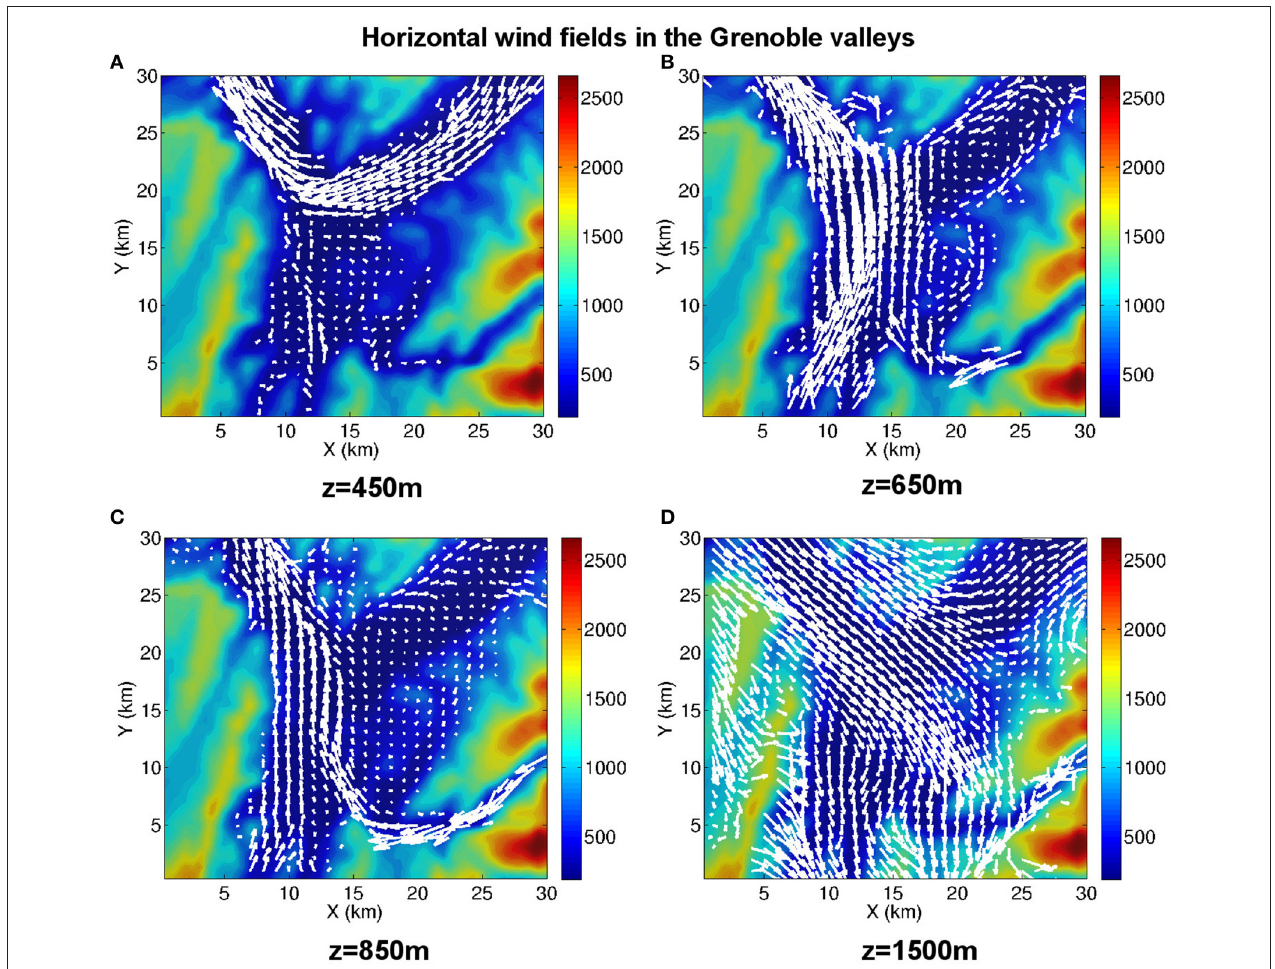
FIGURE 4 | Maps of the wind at a given altitude during episode I 6 at 06:00 UTC on December 28. (A) z = 450 m ASL; (B) z = 650 m ASL; (C) z = 850 m ASL; (D) z = 1500 m